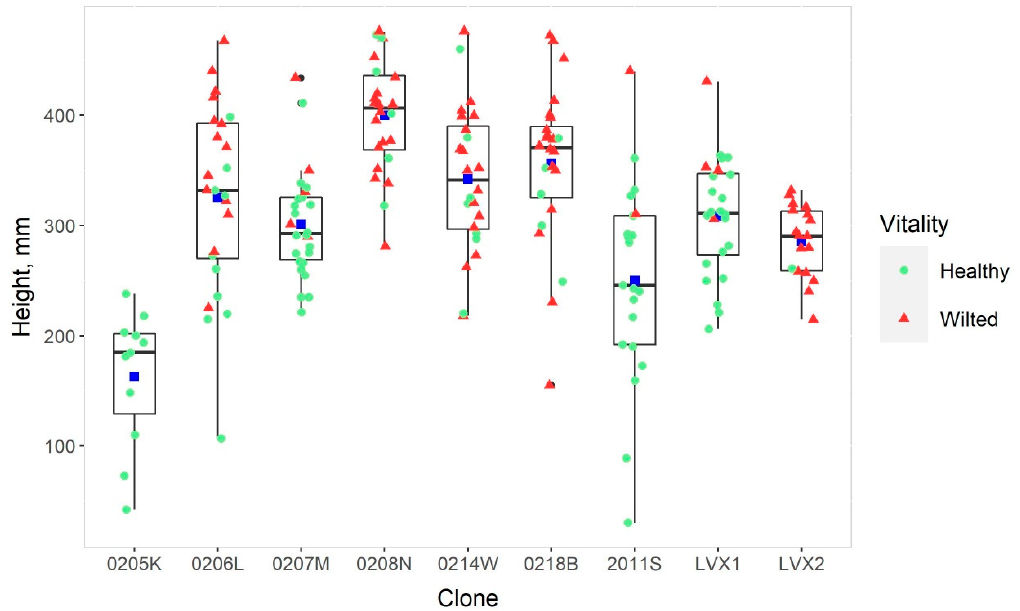
Figure 1. Salix alba leading shoot height and occurrences of wilting shoots (box represent interquartile range; median is shown as the centre horizontal line in the box; whiskers show minimum and maximum observed values plus 1.5*interquartile range or minus 1.5*interquartile range, respectively; black dots show outliers; mean shoot height is represented by the blue squares).